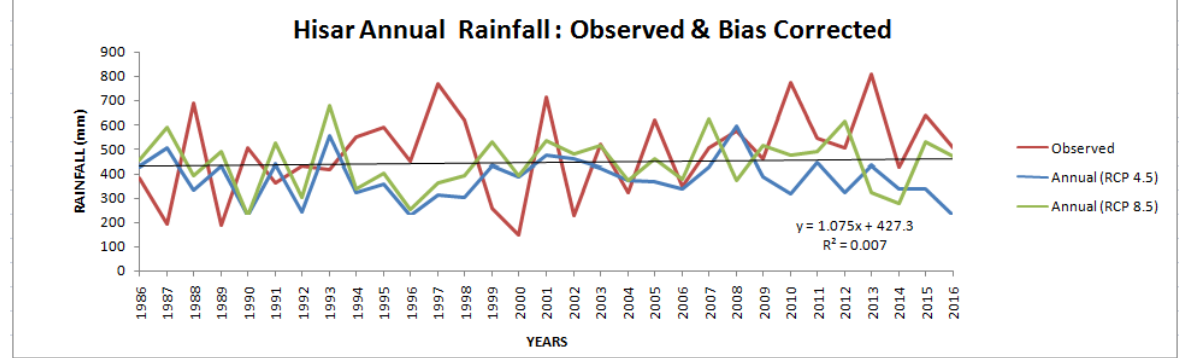
Figure 4: Annual Observed Rainfall and Variations for Baseline Period (1986-2016): HISAR